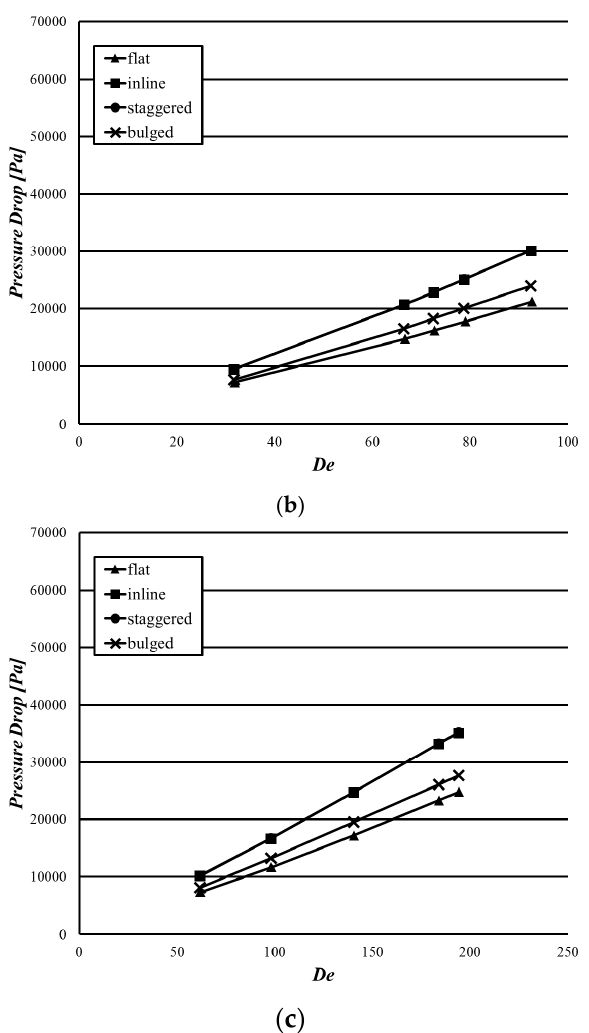
Figure 10. Pressure drop at the helically-coiled tube with various De : ( a ) T hot,in = 45 ℃ ; ( b ) T hot,in = 55 ℃ ; and ( c ) T hot,in = 70 ℃ .